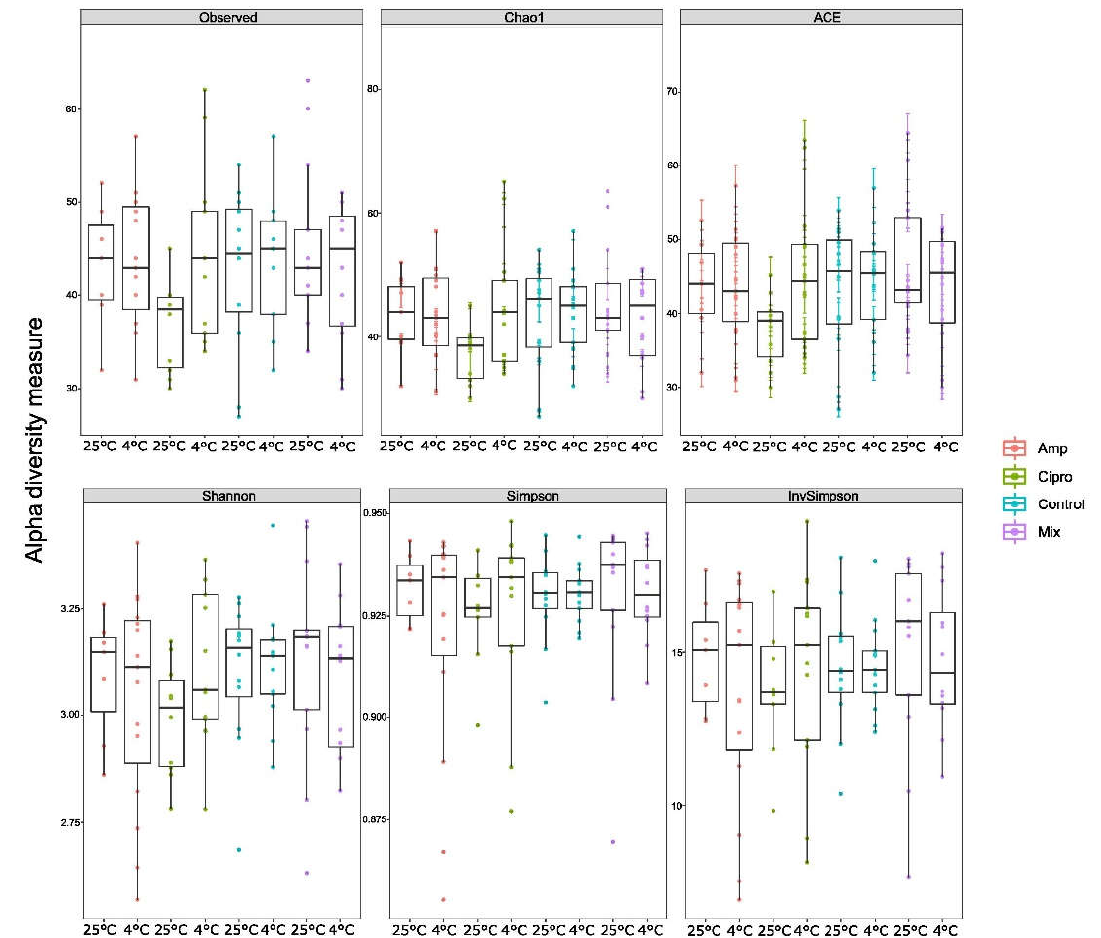
Figure 8. Alpha-diversity, as assessed by estimators of richness (Chao1, ACE) and diversity (Shannon, Simpson) in Lobaria pulmonaria samples treated with different antibiotics and temperatures. Median estimates were compared across cohorts using the Kruskal–Wallis test ( p > 0.05). Boxes represent the interquartile range, lines indicate medians, and whiskers indicate the range of data. Table 1. Heteroscedasticity in diversity estimates for the bacterial dataset, as assessed with Kruskal– Wallis rank sum test.